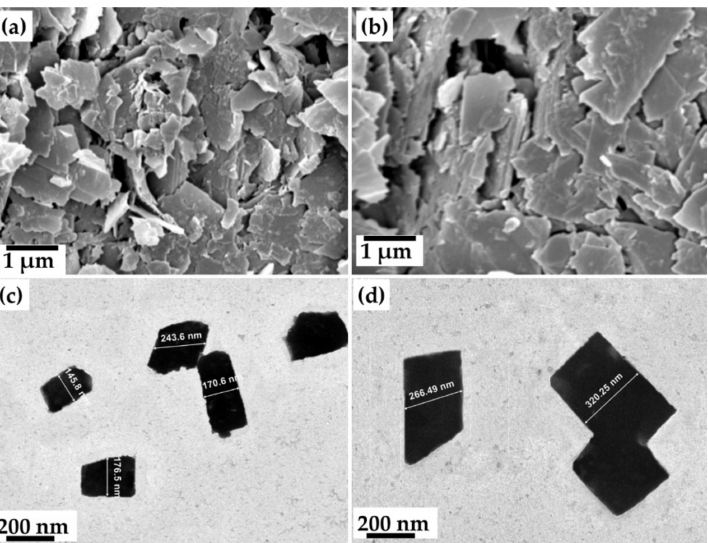
Figure 2. Typical ( a , b ) SEM images and ( c , d ) TEM images of as-synthesized ZnO nanosheets.